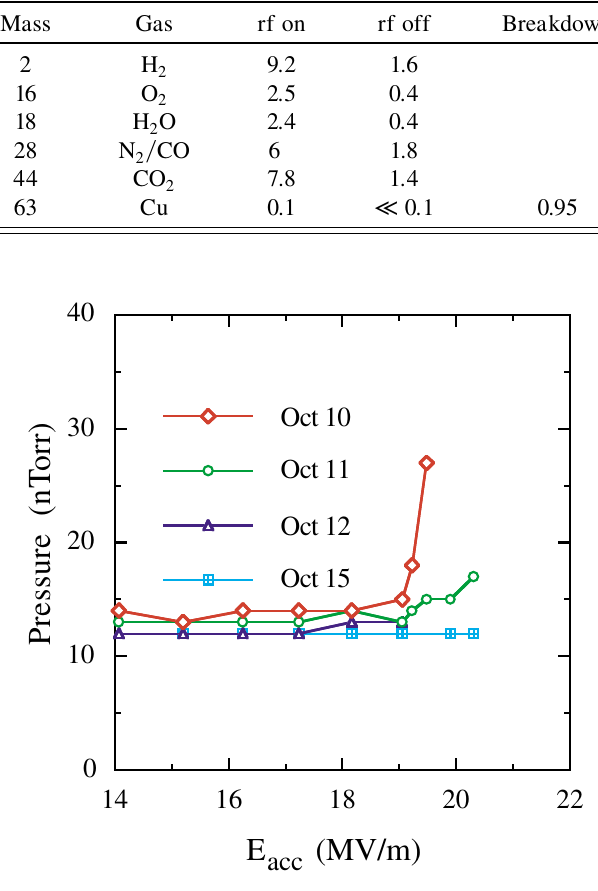
FIG. 11. The frequency spectrum measured with the spec- trum analyzer.